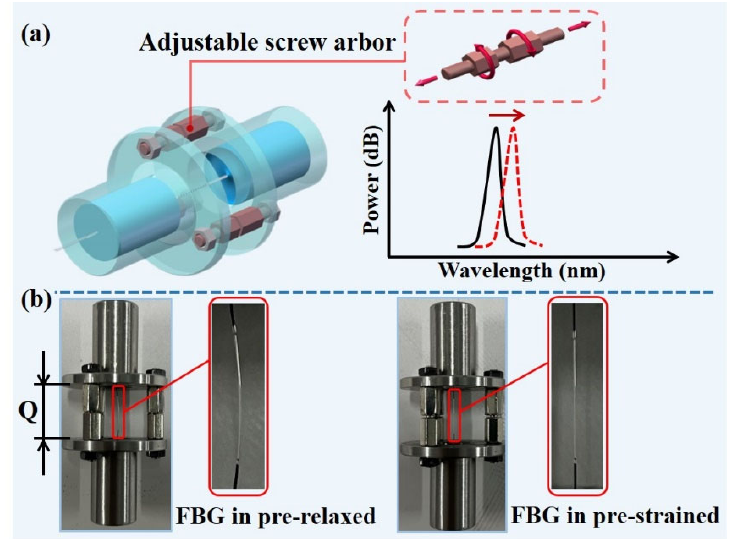
Figure 9. The sensor with adjustable structure: ( a ) 3D schematic diagram of the sensor; ( b ) different FBG states after adjusting the screw arbors.